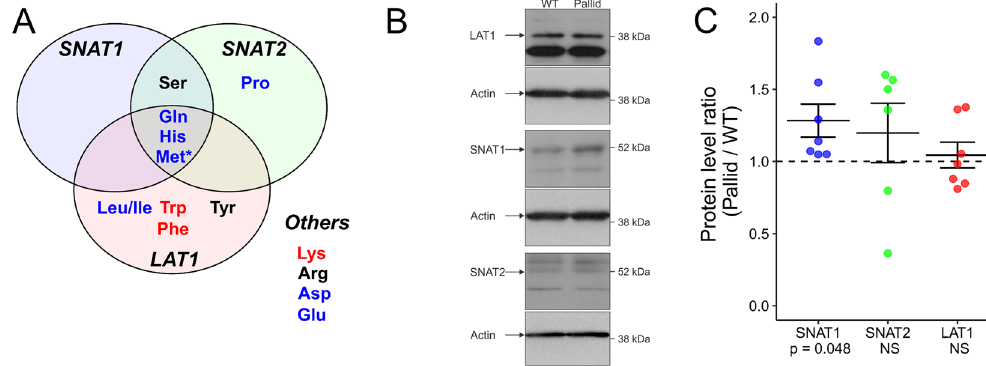
Figure 4. Changes in amino acid transporters and substrates in the hippocampus of pallid mice. ( A ) Substrate specificity of the detected amino acids for System A (SNAT1 and SNAT2), System L (LAT1) or other (Others) amino acid transporter systems. Amino acid names in blue and red are upregulated and downregulated in pallid hippocampi, respectively. * While levels of methionine (Met) are not significantly changed, its product metabolite methylthioadenosine (MTA) is upregulated in pallid mice. ( B ) Representative immunoblots of whole-tissue extracts prepared from hippocampi of P1 wild-type (WT) or pallid mice, probed with antibodies to LAT1, SNAT1 or SNAT2, and subsequently re-probed with an antibody to β -actin. All sets of immunoblots are shown in Supplemental 1 and Fig. S6. The pairs of WT and pallid samples used in panel B for LAT1, SNAT1 and SNAT2 correspond to sets 2, 1 and 3 in Supplemental 1 and Fig. S6, respectively. ( C ) Values derived from densitometric analysis were background-corrected, normalized to those obtained for β -actin, and are represented as a Pallid/WT ratio for each pair of hippocampi extracts that was processed in parallel. Indicated are the means ± SEM (standard error of the mean) of 6 to 7 pairs of WT and pallid animals. P values were derived from 2-tail one-sample t-tests of each data group against the theoretical value of 1 (dashed line). When P values were higher than 0.05 differences were deemed not significant (NS). Notice a small but statistically significant upregulation of SNAT1 levels in pallid hippocampi compared to wild-type (WT) control. No significant changes were found in LAT1 expression levels, while SNAT2 levels display a modest non-significant increase compared to WT but also a high variability.